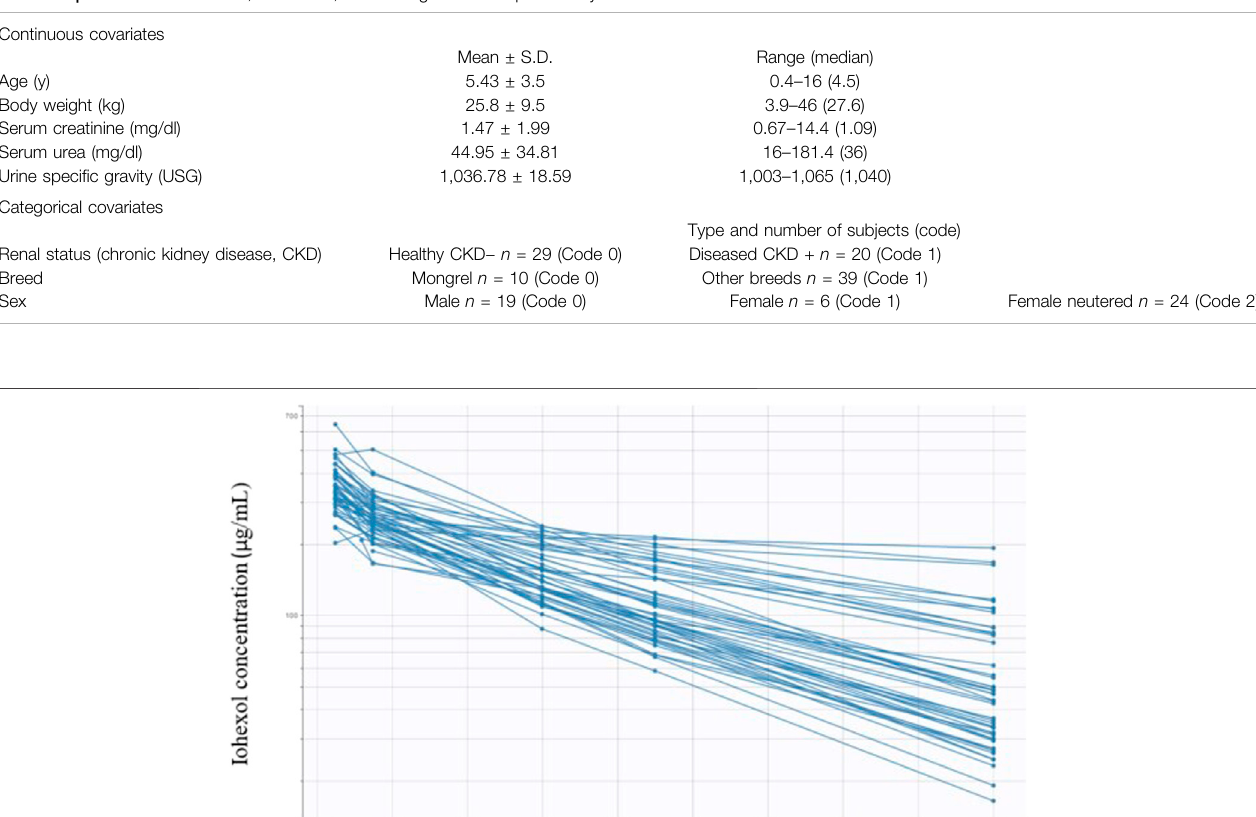
Frontiers in Pharmacology |